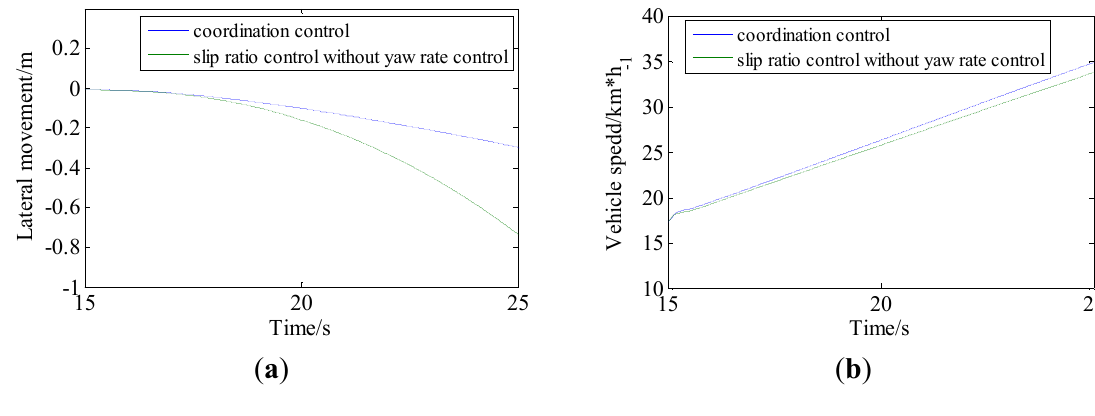
Figure 19. Comparison of experiment results of proposed strategy and normal strategy on variation friction coefficient road: ( a ) lateral movement and ( b ) acceleration performance. Table 9. Performance of acceleration slip regulation on variation friction coefficient road